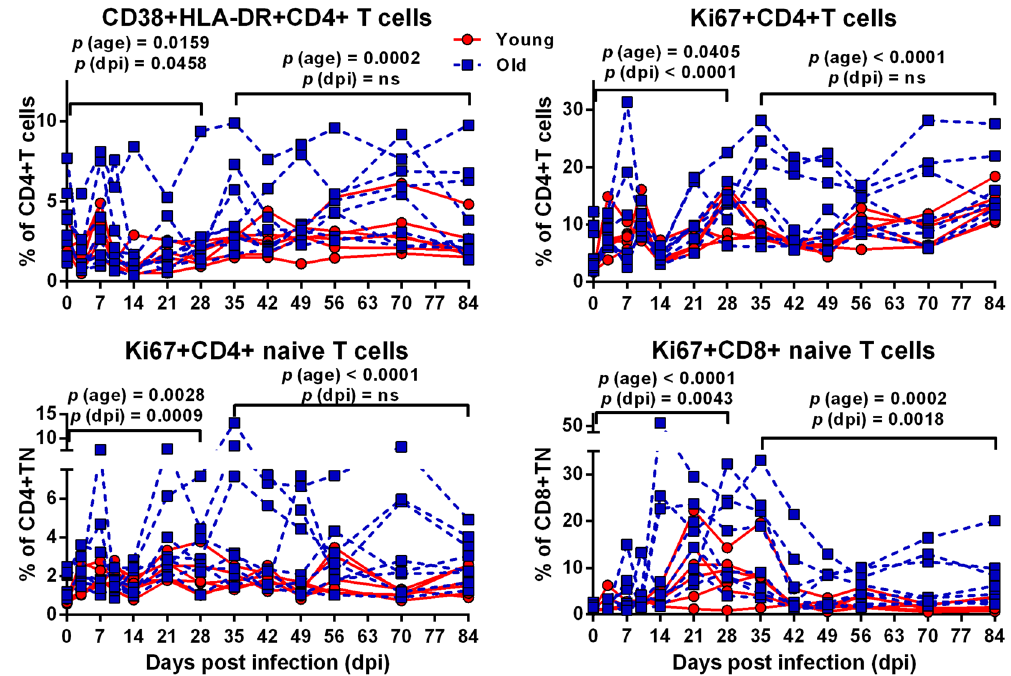
Figure 3. The naïve T cell subsets of old ChRM have an increased level of proliferation. ( a ) Dot plots shows increased levels of CD38 + HLA-DR + CD4 + T cells, Ki67 + CD4 + T cells, Ki67 + CD4 + naïve T cells, Ki67 + CD8 + T cells and Ki67 + CD8 + naïve T cells in old (n = 8, blue square) compared with young (n = 6, red circle) animals during early infection. P (dpi) < 0.05, statistically significant differences over the acute or postacute phase, as determined by two-way ANOVA. P (age) < 0.05, statistically significant differences between the young and old groups, as determined by two-way